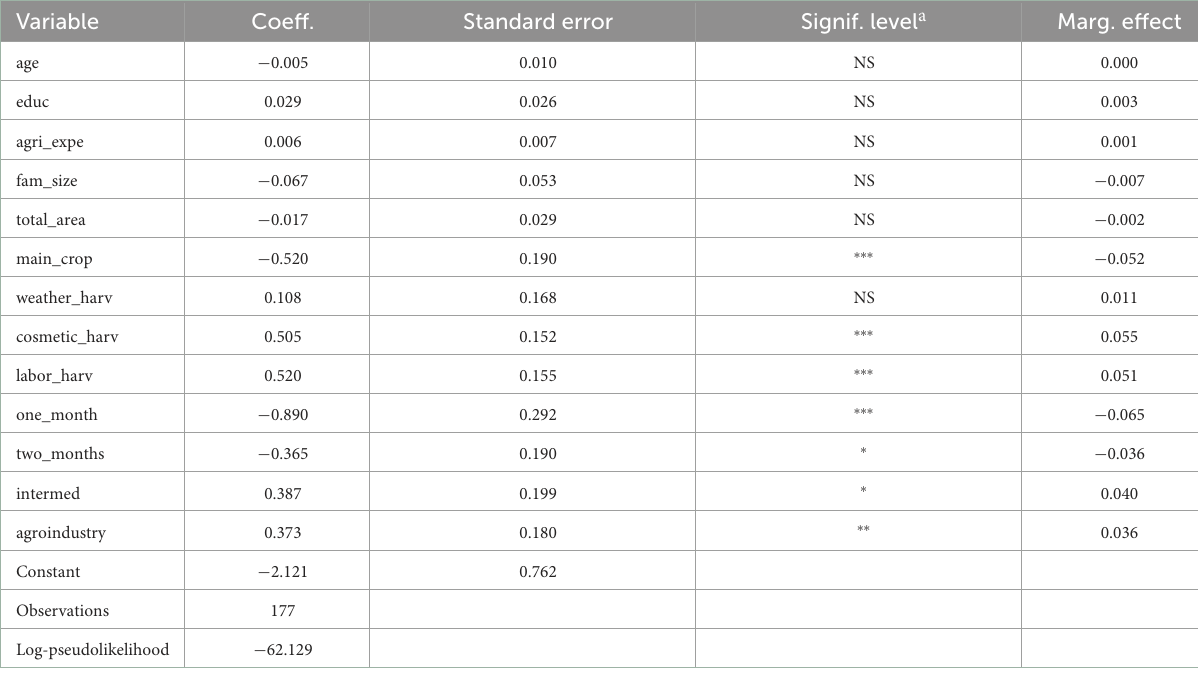
TABLE 7 Fractional regression model explaining variation in food loss (FL) reported by farmers surveyed in two agricultural regions of Chile during June and September of 2020. Variable